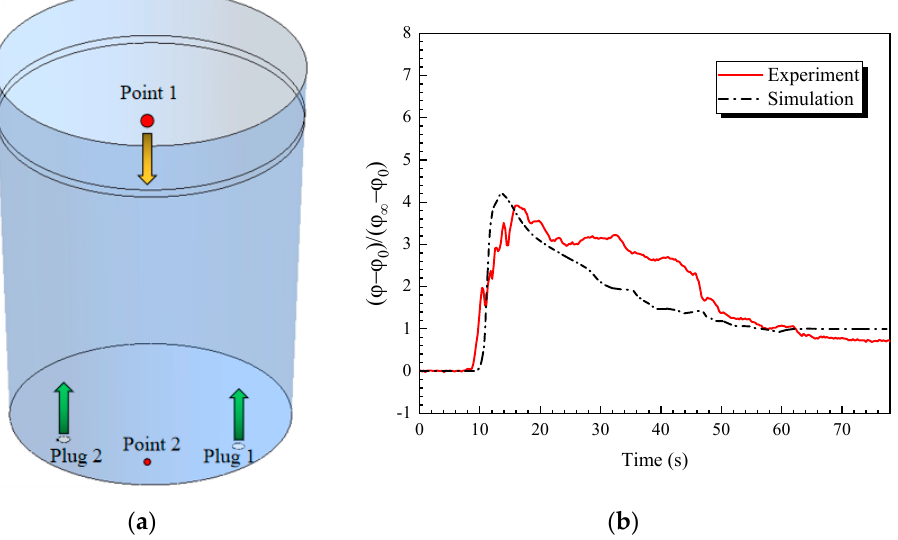
Figure 4. Comparison of mixing time: ( a ) arrangement of injection position, detection point, and ( b ) comparison result.